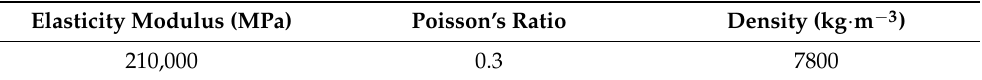
Table 1. Model material parameters.